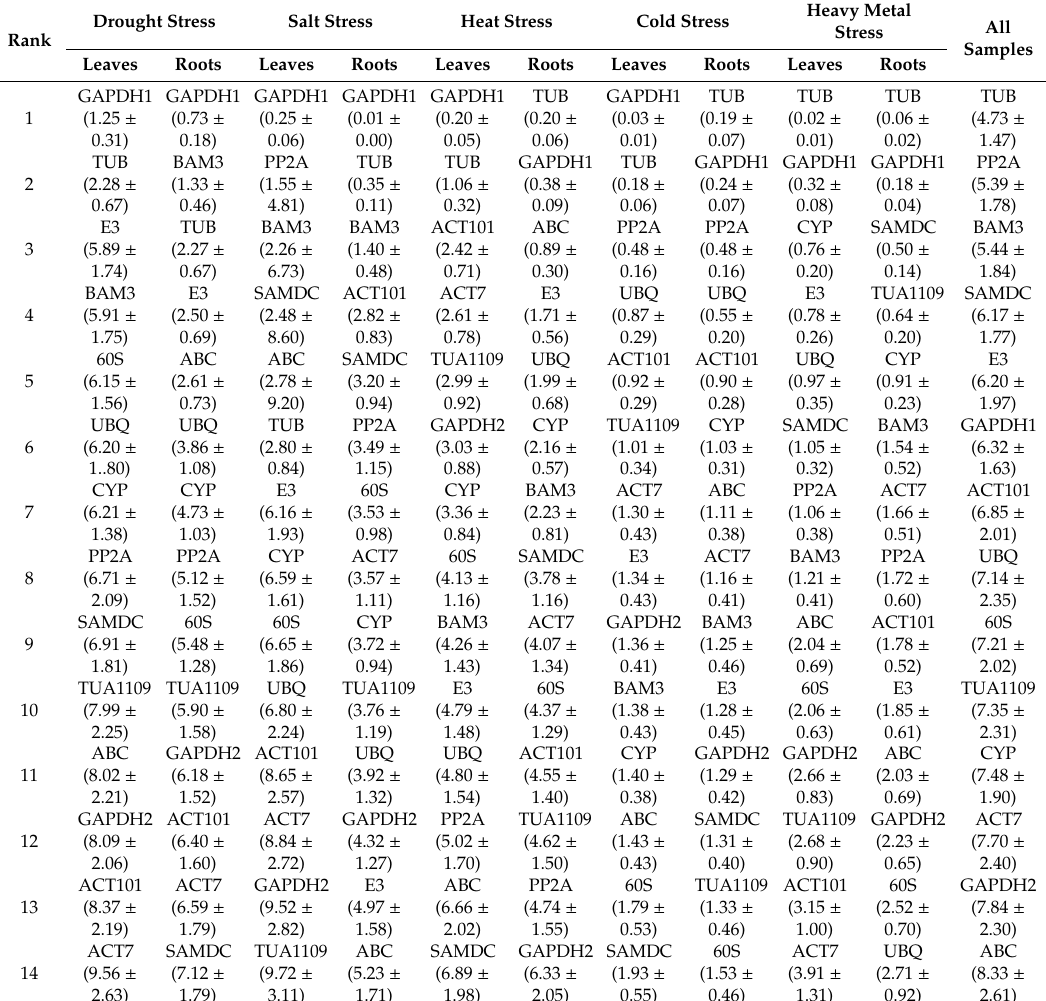
Table 3. Expression stability values for 14 white clover candidate reference genes calculated using